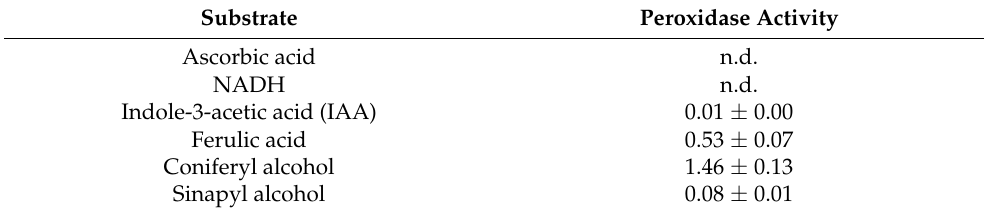
Table 4. Enzymatic activities (nkat µ g − 1 protein) of purified peroxidase PpaPrx19 in the presence of different substrates. Data presented are average values ± SD of n = 3 experiments. n.d. not detected. Substrate Peroxidase Activity Ascorbic acid n.d. NADH n.d.